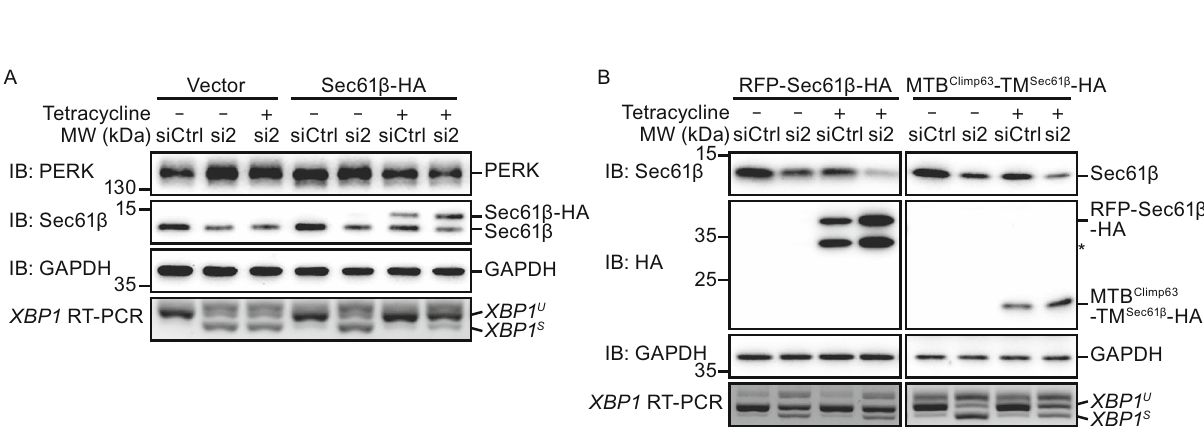
Figure 4. Sec61 β -regulated ER homeostasis requires microtubule binding. (A) SiRNA transfected Flp-In-293 cells were treated with tetracycline as indicated. The samples were analyzed by Western blotting and agarose gel. (B) As in (A), but in cells